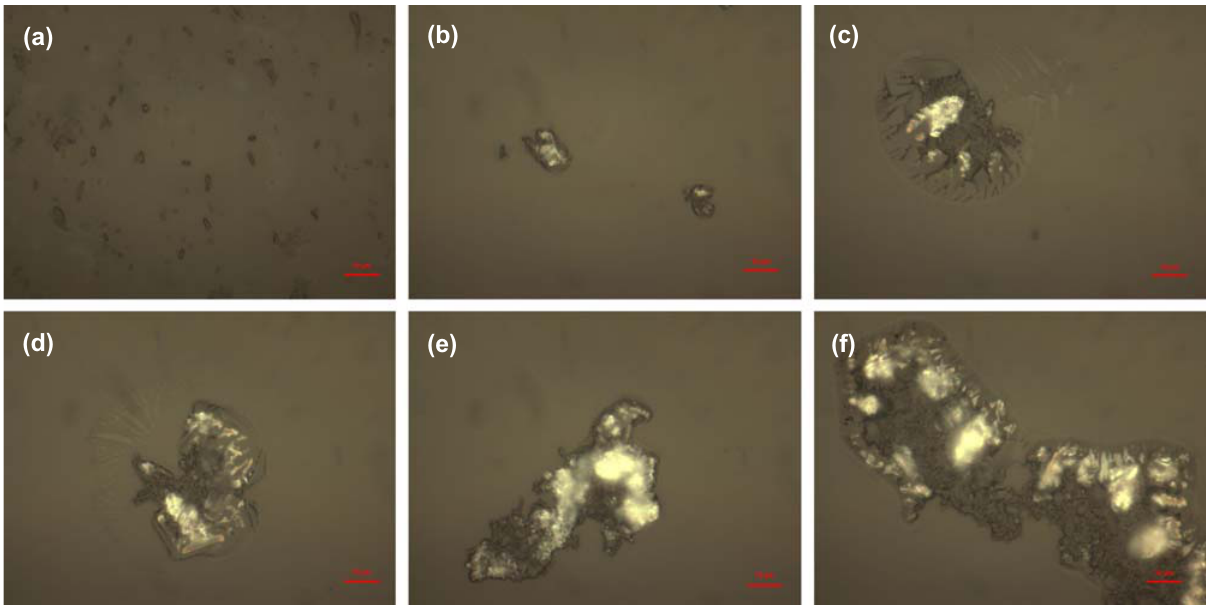
Figure 1: Microscopic images of B. subtilis after di ff erent adsorption time, including control group ( a ) , 15 min ( b ) , 30 min ( c ) , 45 min ( d ) , 90 min ( e ) and 180 min ( f )